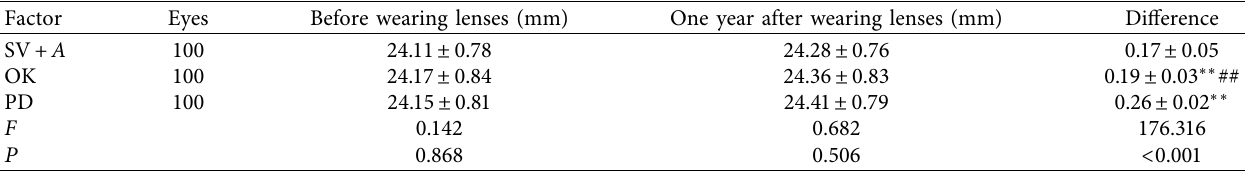
Table 3: Comparison of axial length changes before and after wearing lenses between the SV +A, OK, and PD groups. Factor